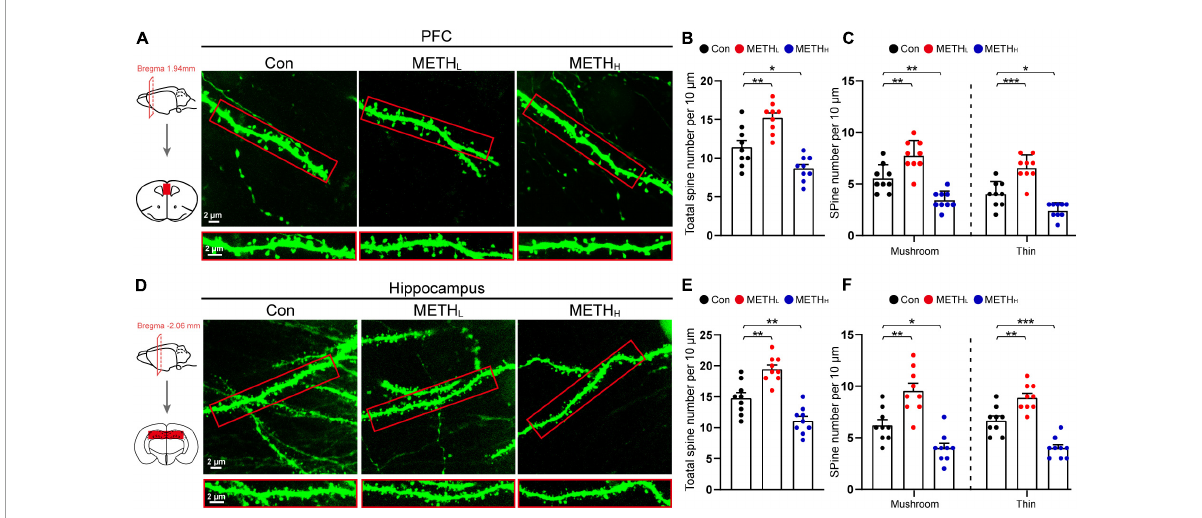
FIGURE2 Effect of different doses of methamphetamine on structural plasticity of spines. (A) Representative images of spines by Lucifer Yellow intra-neuronal injection in cortex. The red squares were the areas where the Lucifer Yellow dye was injected. (B) Quantification of total spine number in cortex. One-way ANOVA, F (2, 26) = 22.978, p < 0.001. (C) Quantification of mushroom-type and thin-type spine numbers in cortex. One-way ANOVA, mushroom: F (2, 26) = 22.69, p < 0.001, thin: F (2, 26) = 32.719, p < 0.001. (D) Representative images of spines by Lucifer Yellow intra-neuronal injection in hippocampus. (E) Quantification of total spine number in hippocampus. One-way ANOVA, F (2, 26) = 29.747, p < 0.001. (F) Quantification of mushroom-type and thin-type spine number in hippocampus. One-way ANOVA, mushroom: F (2, 26) = 22.892, p < 0.001, thin: F (2, 26) = 37.096, p < 0.001. n = 9 neurons, 3 neurons per mouse. * p < 0.05, ** p < 0.01, *** p < 0.001 by one-way ANOVA and Dunnett’s post hoc analysis.